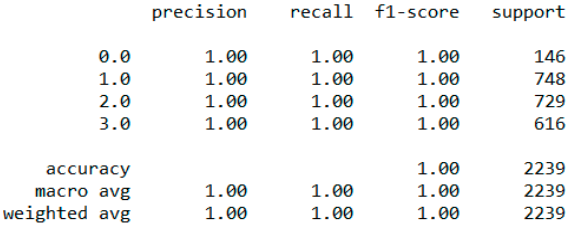
Figure 13. Performance metric of the “Decision Tree” classification with a 5-fold cross validation.